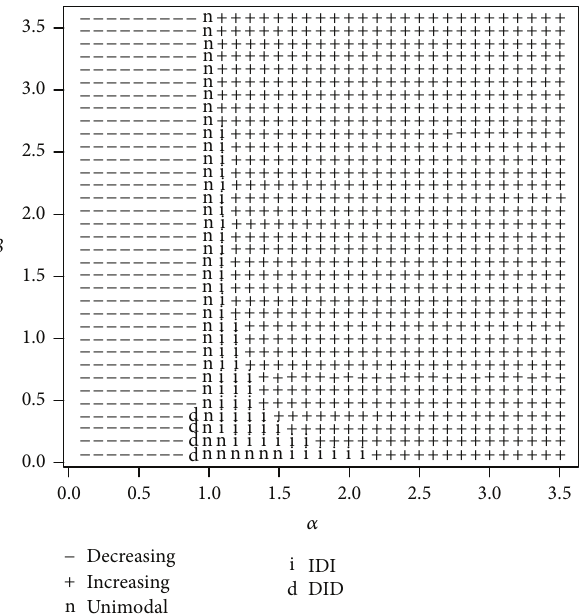
Figure 3: Shapes of the hazard function of TN (𝛼,𝛽)